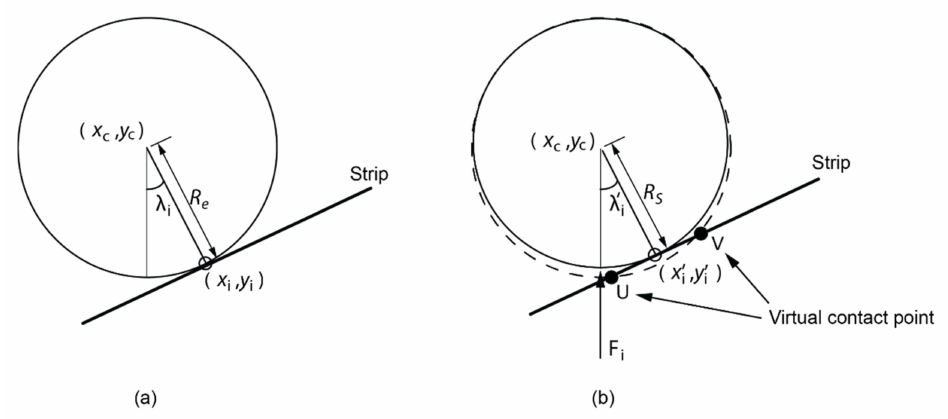
Figure 14. Illustration of ( a ) the original contact model; ( b ) the Hertz contact